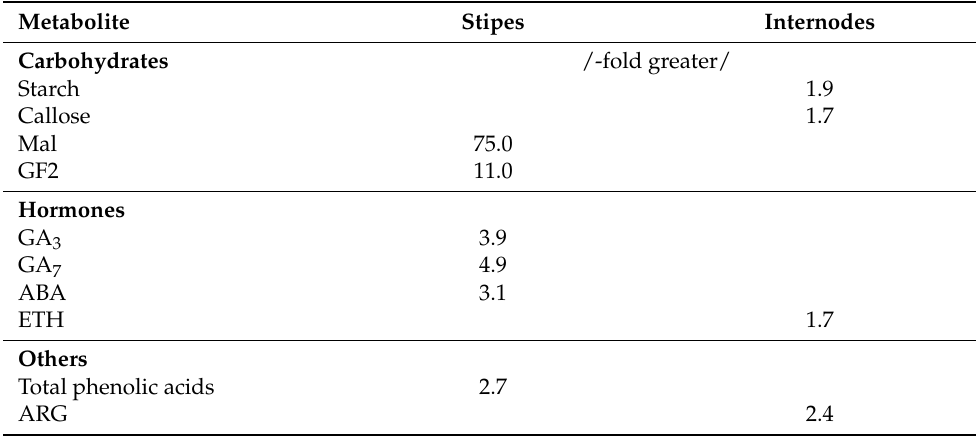
Table 1. Differences in selected metabolites that can be imperative for origin of somatic embryos by the unicellular or multicellular pathways.